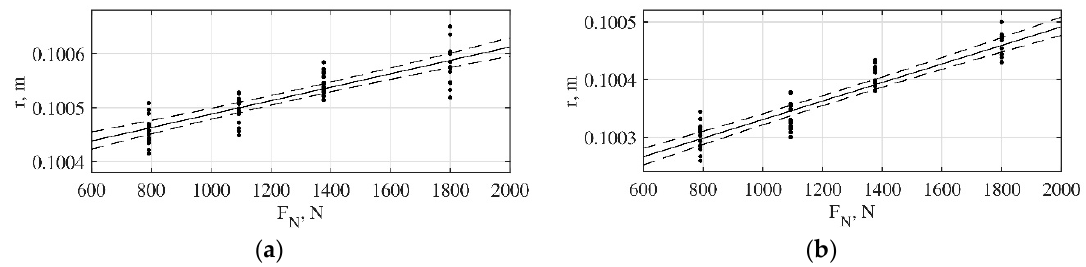
Figure 12. Linear regression with a 95% confidence interval estimated for ( a ) left wheel; ( b ) right wheel.